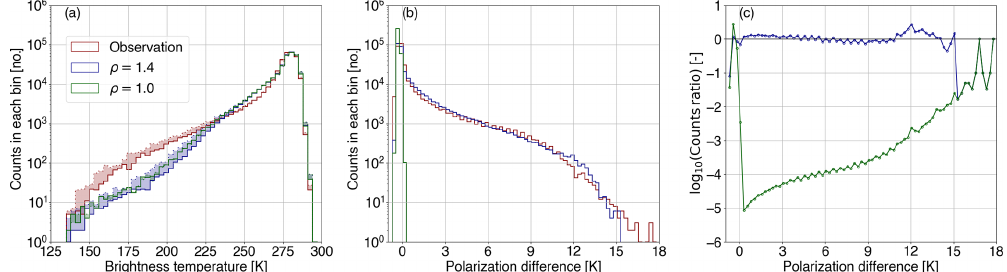
Figure 5. (a) Histograms of the brightness temperature at 166.5GHz as observed ( T o of 1.4 (blue) and 1.0 (green; control run); solid and dashed lines denote the brightness temperature at vertical and horizontal polarization, respectively, and the shaded area highlights their difference. (b) Corresponding histograms of polarization differences (PD) and (c) the divergence between the distributions of PD o and PD b as a function of the polarization difference.